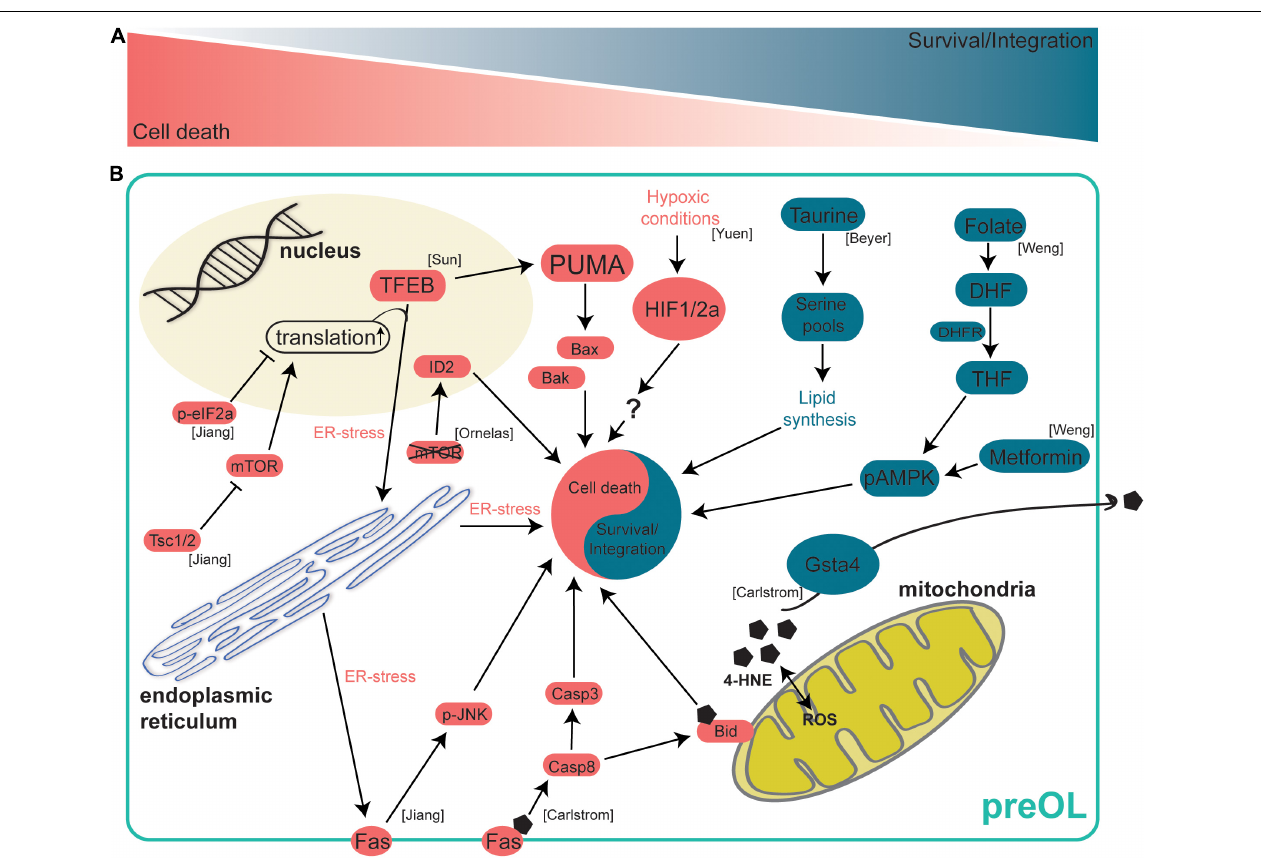
FIGURE 2 | Intrinsic mechanisms regulating preOL survival and integration. After terminal differentiation from OPCs, preOLs must pass through a survival checkpoint during which a majority are lost. At this survival checkpoint a complex web of intracellular signaling mechanisms work to either drive preOL death or to encourage survival and integration. (A) A schematic representation of the survival checkpoint. PreOLs can either be driven toward cell death (red) or survival and integration (blue). (B) Intrinsic signaling pathways in preOLs. Pathways in blue promote the survival and integration of preOLs. The metabolite Taurine leads to increased serine pools that are available for lipid synthesis pathways (Beyer et al., 2018). The metabolite folate promotes survival by activating AMPK α phosphorylation (Weng et al., 2017). Gsta4 regulates oxidative stress via extracellular transport of 4-HNE (Carlstrom et al., 2020). Pathways in red promote cell death in preOLs. Increased 4-HNE load leads to increased Fas-Casp8-Bid signaling (Carlstrom et al., 2020). Hypoxic conditions result in increased HIF1/2a (Yuen et al., 2014). mTOR deletion leads to increased expression of the oligodendrocyte maturation inhibiting promotor ID2 (Ornelas et al., 2020). Reduction of Tsc1/2 results in hyperactive mTOR,